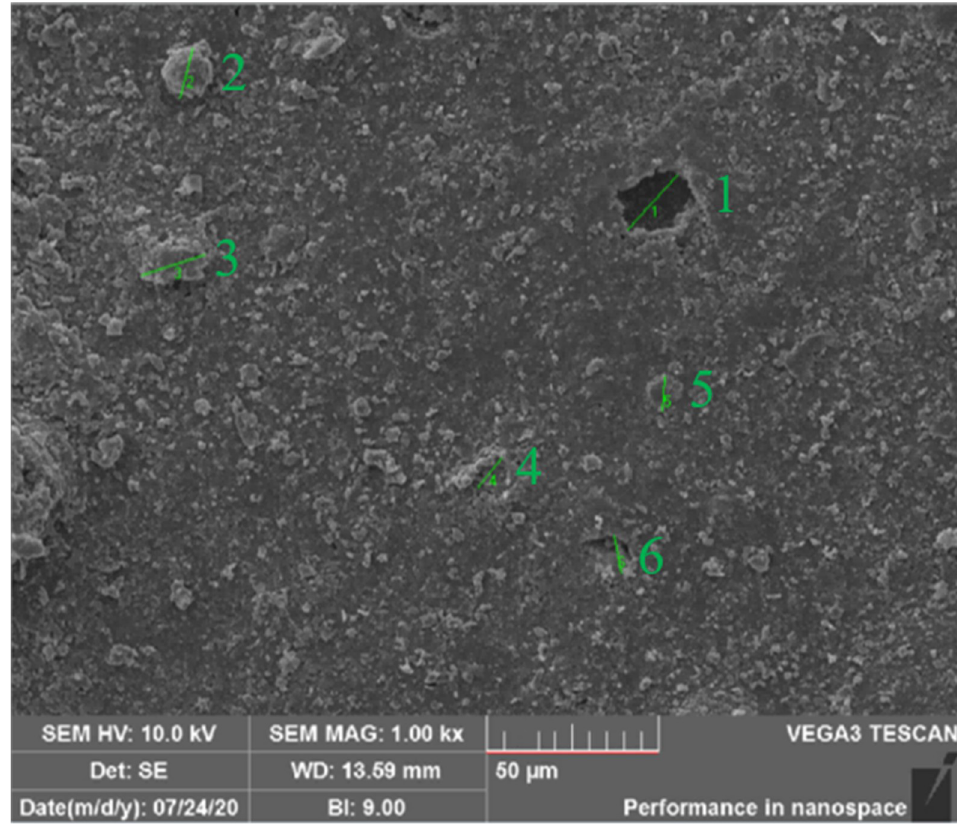
marily designated as ageing level 1, ageing level 2 and ageing level 3, respectively. Level 1: The microscopic morphology of RTV samples in this level with a particle diameter of 10–40 μ m is shown in Fig 6A. It can be seen that surface of RTV sample is relatively flat, and only some small bumps and less obvious damage exists. Level 2: The microscopic morphology of RTV samples in this level with a particle diameter of 40–100 μ m is shown in Fig 6B. And it is shown that the number of particles and holes increases obviously. Level 3: The microscopic morphology of RTV samples in this level with a particle diameter more than 100 μ m is shown in Fig 6C. The surface morphology of RTV sample in this level is pretty rough, and RTV sample is nearly destroyed and huge holes and gullies can be found on the surface. 2) Surface morphology. To further evaluate the surface state of RTV samples, surface mor- phological parameters should be acquired. A portable video microscope with the magnification ranging from 1 to 225 was used to test all the 20 samples. And the morphology pictures of RTV